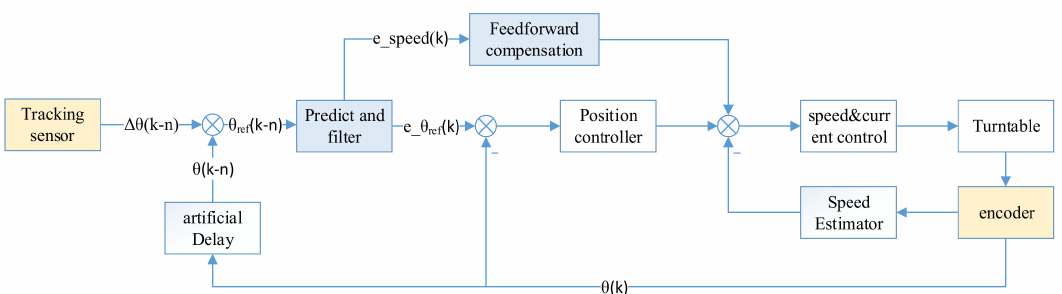
Figure 3. The spectrometer on-axis tracking control